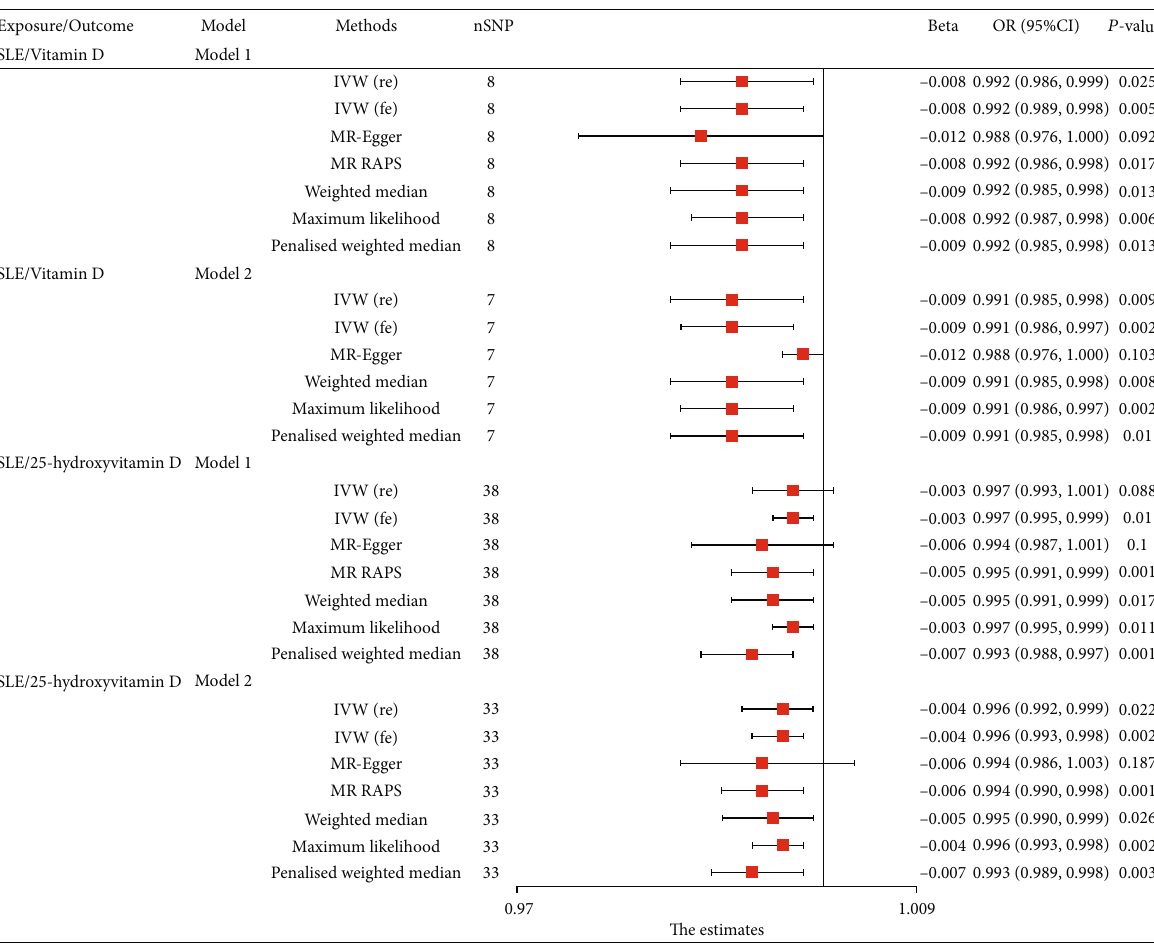
Figure 2: MR results for causal role of systemic lupus erythematosus on serum vitamin D and 25-hydroxyvitamin D levels. MR-RAPS method was not applicable for causal e ff ect from SLE on vitamin D with model 2 for limited SNPs. SLE: systemic lupus erythematosus; SNP: single-nucleotide polymorphisms; IVW: inverse variance weighted; MR-RAPS: MR-robust adjusted pro fi le